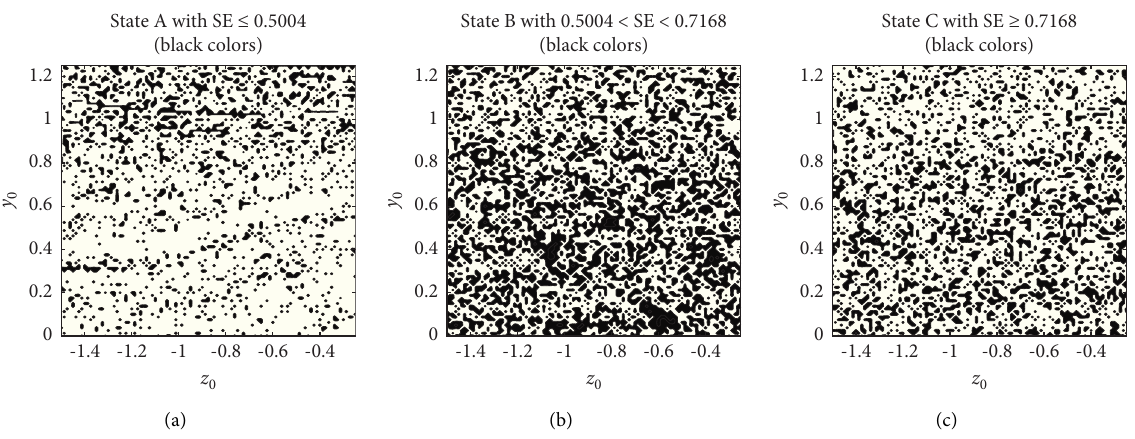
Figure 10: Dispersion of spectral entropy in the y